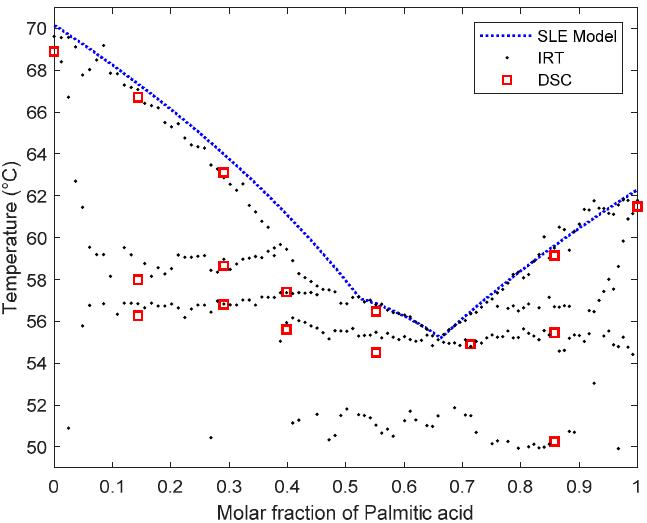
Table 3. Comparison between experimental and literature properties of the PA–SA binary mixture.